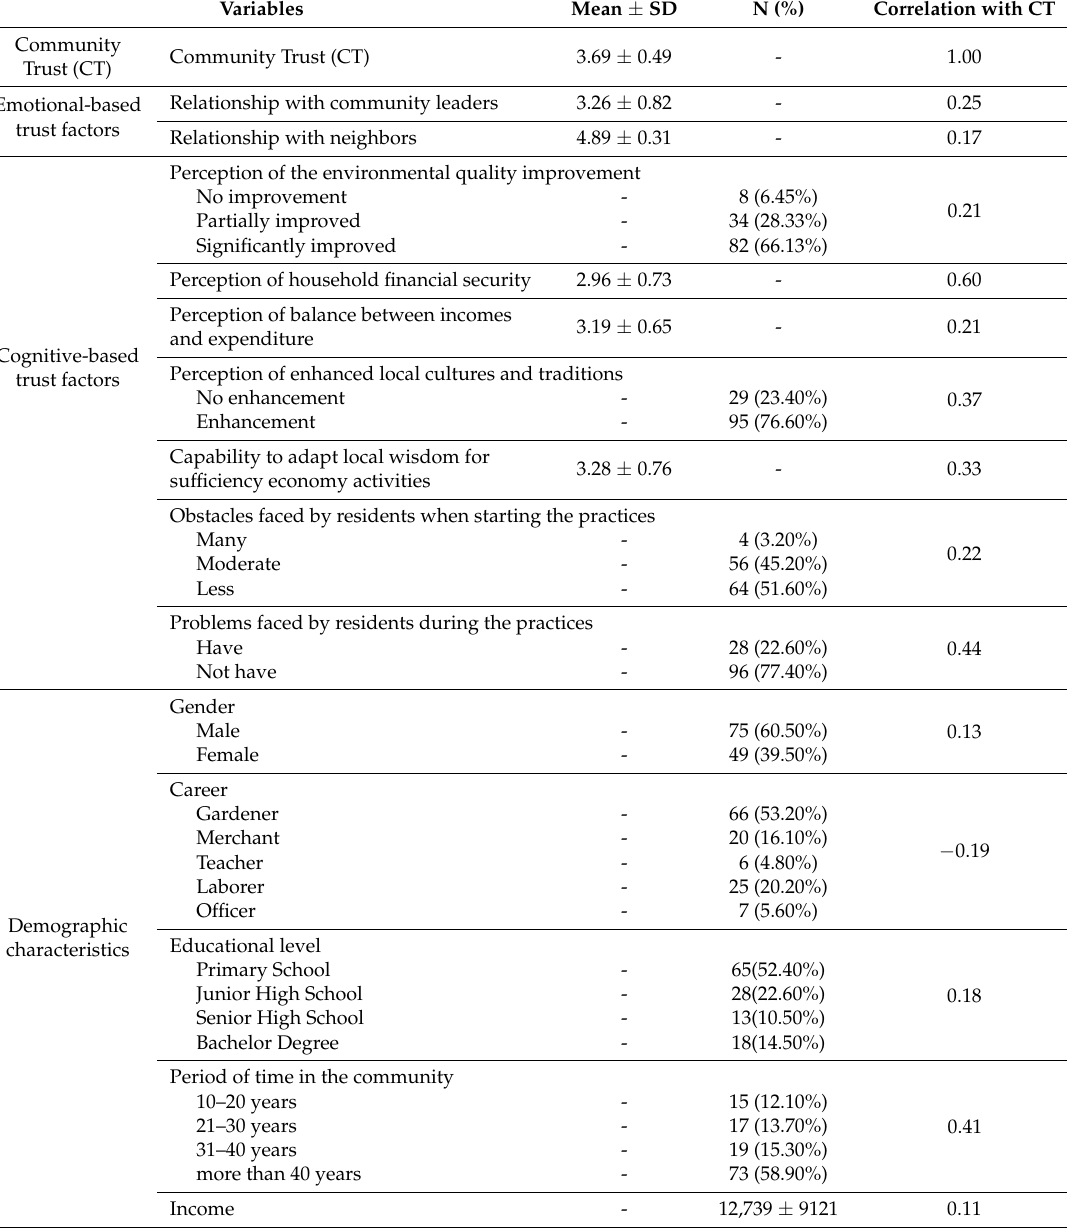
Table 4. Average trust scores and descriptive statistics of potential